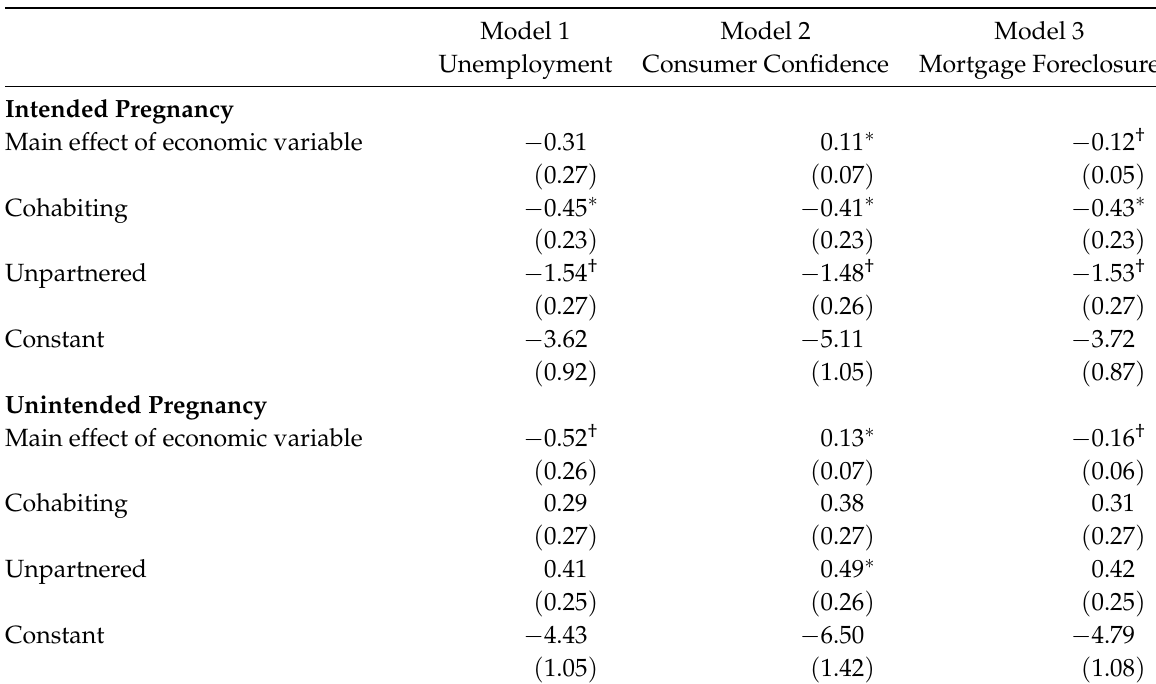
Table 2: Coefficients from mlogit models predicting intended and unintended pregnancy relative to no pregnancy by state-level economic conditions with covariates for partnership status. (Sample: all fertile adult women without a college degree. n =